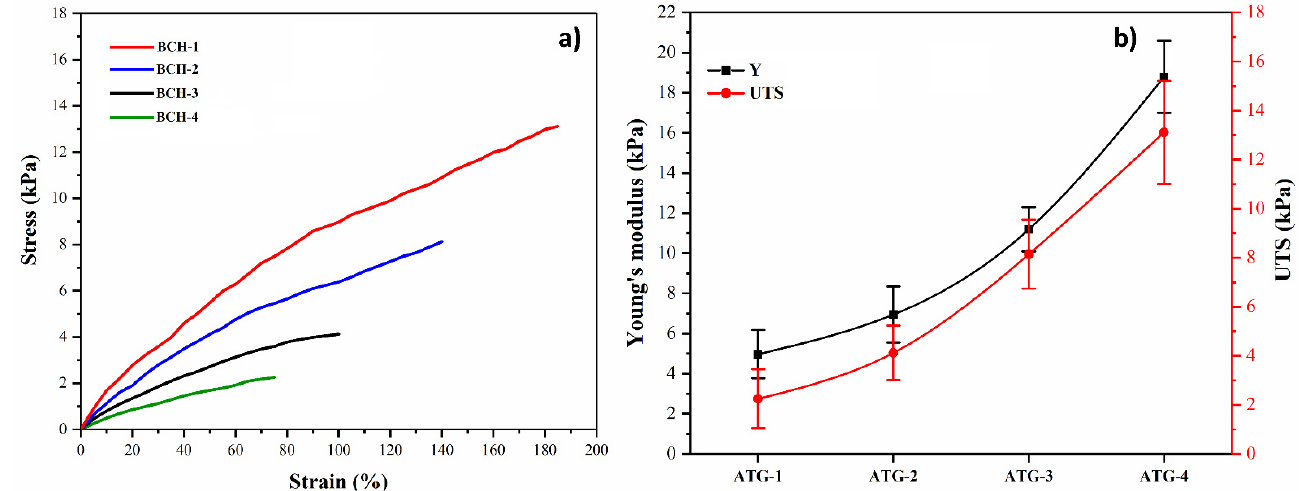
Figure 5. The mechanical behavior of all hydrogels was studied: ( a ) tensile stress–strain curve and ( b ) relationship between Young’s modulus and ultimate tensile strength.